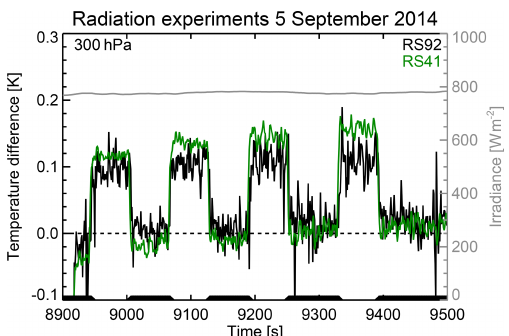
Figure 7. Results of radiation tests with the RS41 (green) and RS92 (black) radiosondes at 3hPa with 5ms − 1 ventilation flow. The so- lar irradiance during the test (thin grey trace) was approximately 650Wm − 2 . The thick black segments along the x axis indicate when the shutter was closed. During shutter open periods the sensor was illuminated for